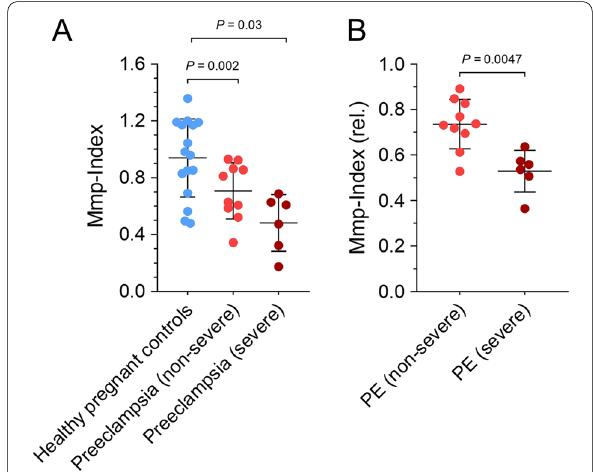
Fig. 2 Platelet mitochondrial membrane depolarization reflects the disease severity of patients with preeclampsia . A Subgroup analysis of PE patients with severe (n 6) and non-severe (n 10) PE showed = = a significantly reduced Mmp-Index compared to pregnant controls (p 0.03 and p 0.002). B Relative Mmp-Index ratios are significantly = = lower in severe compared to non-severe preeclampsia (p 0.0047) =